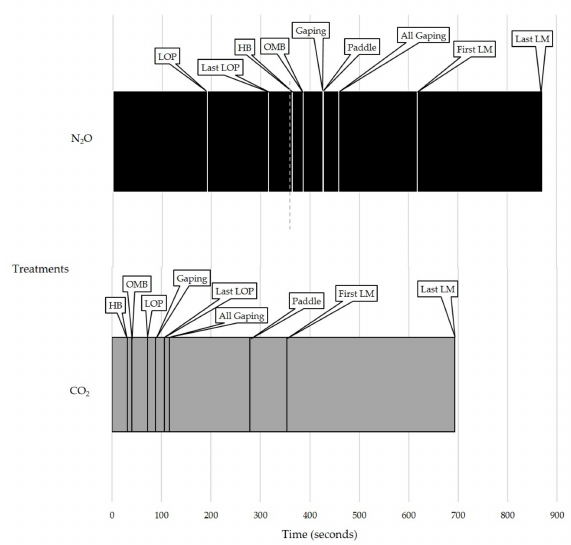
Figure 4. Sequence of latency behaviors for groups of piglets in Experiment 2 for each treatment: N 2 O for six min followed by CO 2 (N 2 O treatment) or just CO 2 (CO 2 treatment). Using the means of each latency, a timeline was created to highlight the difference in the order in which the behaviors occurred. The N 2 O treatment has an additional dotted line at six min (360 s) to represent when the N 2 O was shut off and CO 2 was turned on. HB = heavy breathing, OMB = open-mouth breathing, LOP = loss of posture, LM = last movement, First = first piglet, Last = last